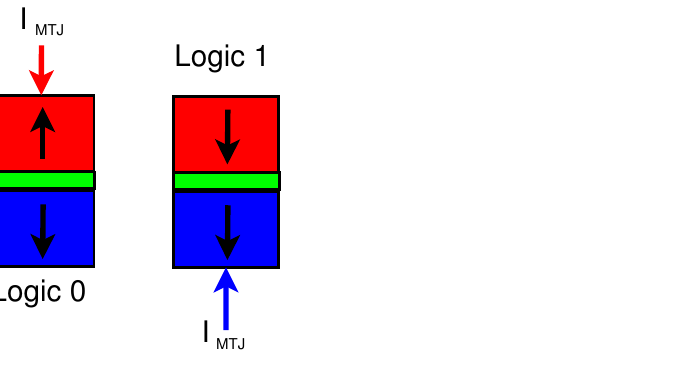
Figure 4. Structure of Magnetic Tunnel Junction (MTJ) with parallel and antiparallel states